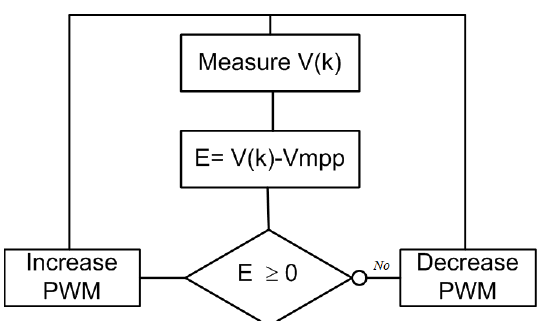
Figure 10. Flowchart of the ANN algorithm of the MPPT method.